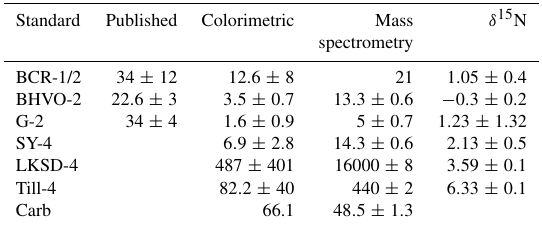
Table 2. Nitrogen and δ 15 N data from colorimetric and mass spec- trometry analyses. Both techniques appear to underestimate N con- centration, perhaps due to incomplete N extraction during combus- tion for mass spectrometry or incomplete recovery of NH + during 4 distillation. Concentrations are in parts per million. Standard Published Colorimetric Mass δ 15 N spectrometry BCR-1/2